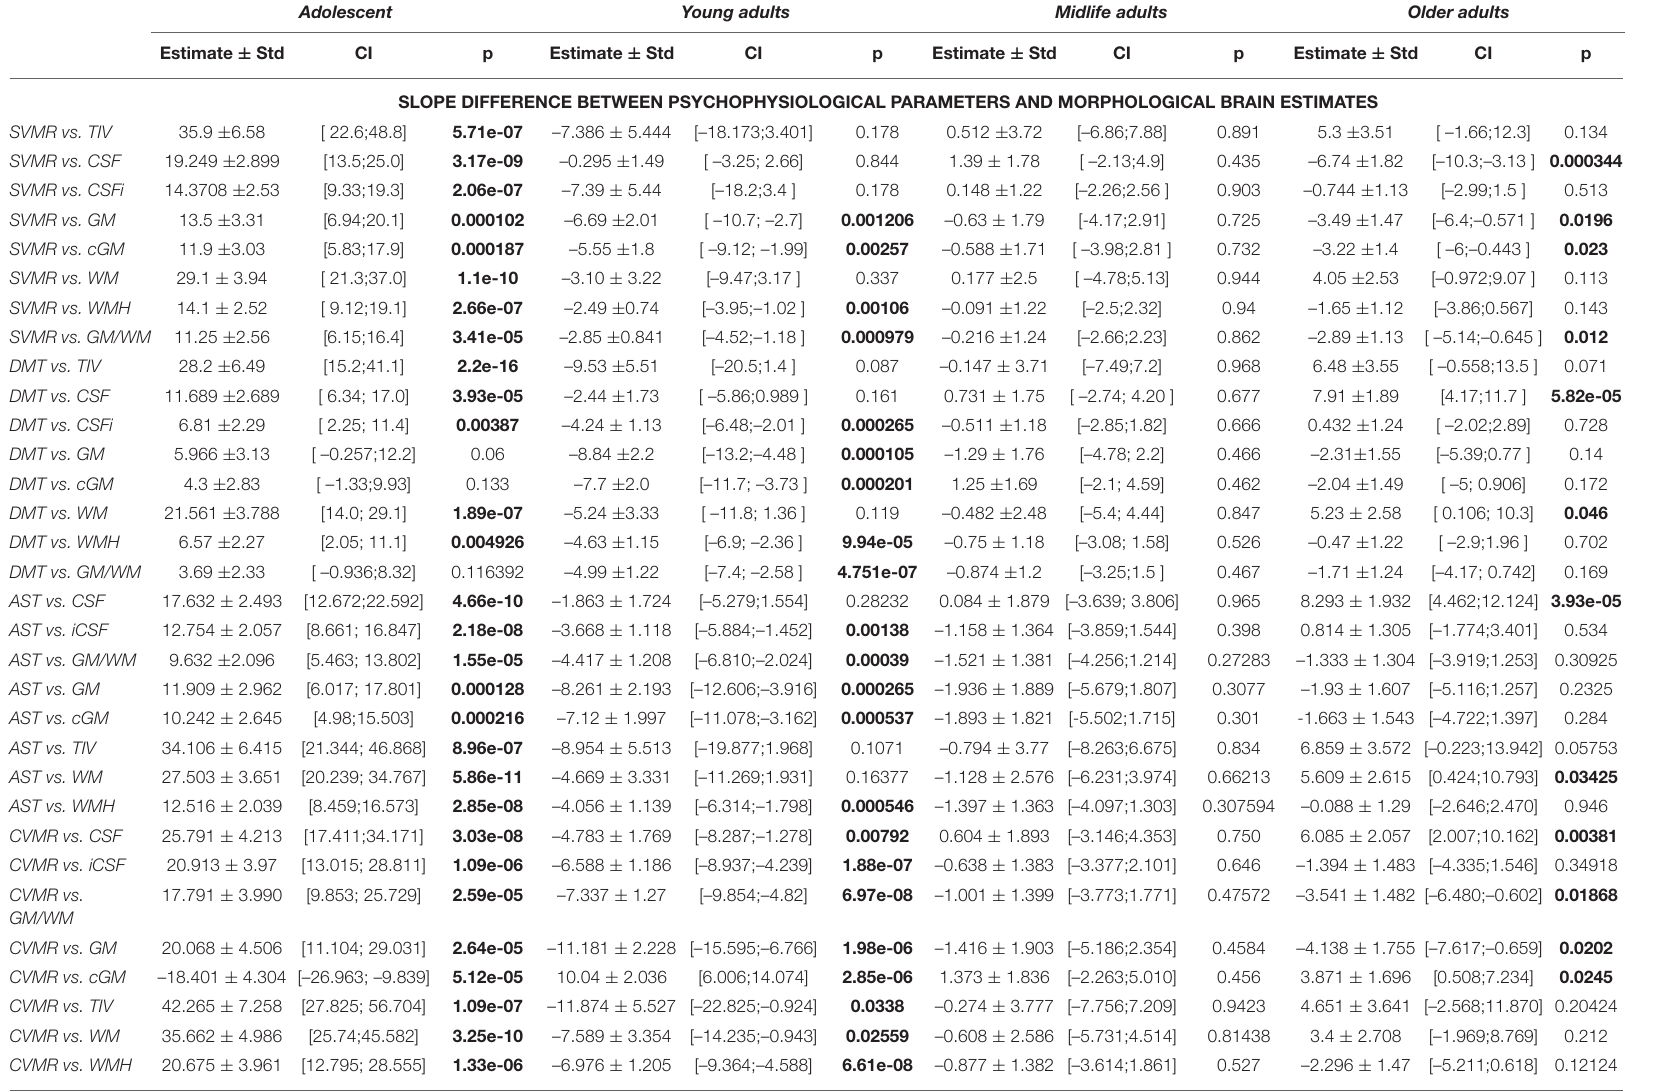
TABLE 6 | Difference of slopes for brain structural data and mean reaction time in psychophysiological